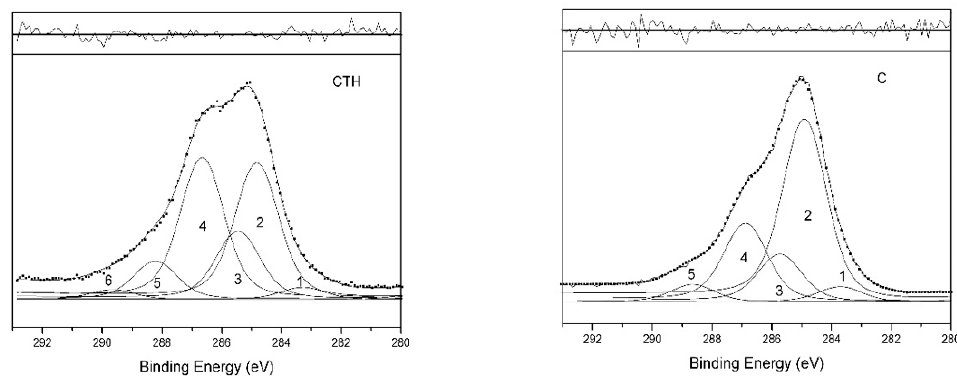
Figure 10. C1s curve-fitted regions of thermally modified (CTH) and unmodified (C) cedar wood samples.